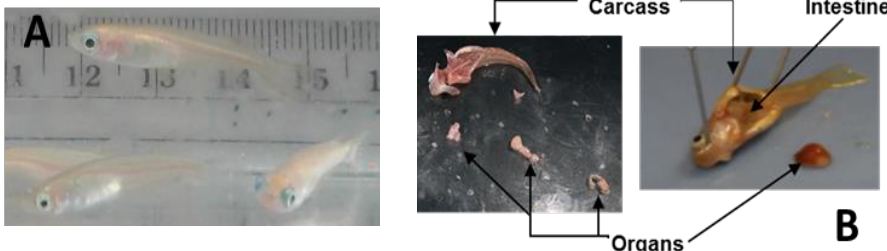
Figure 1. Medaka from the SREL facility. ( A ) Adult Medaka in a tank prior to the dissection and ( B ) dissected Medaka with arrows indicating carcass, organs, and